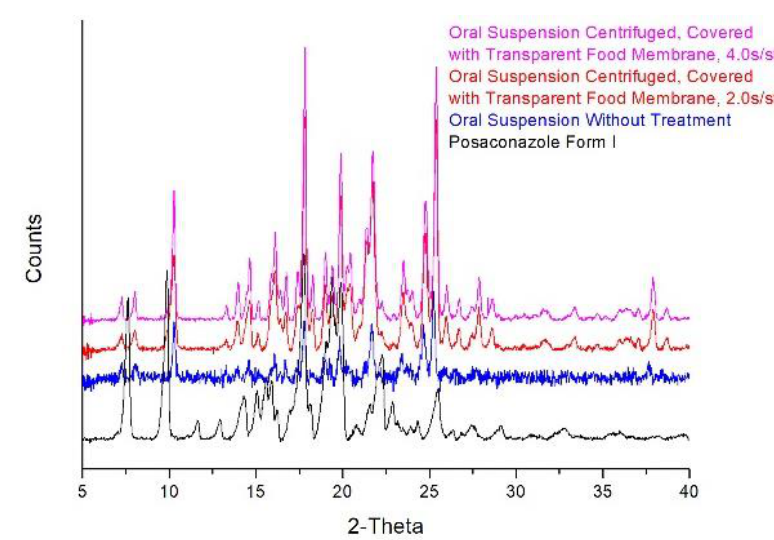
Figure 7. Comparison of Posaconazole oral suspension without treatment and Posaconazole oral suspension treated with the developed method: XRPD patterns of Posaconazole Form I ( black line ), Posaconazole oral suspension without treatment ( blue line ) and Posaconazole oral suspension centrifuged and covered with the transparent food membrane recorded with 2.0 s/step ( red line ) and 4.0 s/step scanning rate ( magenta line ).